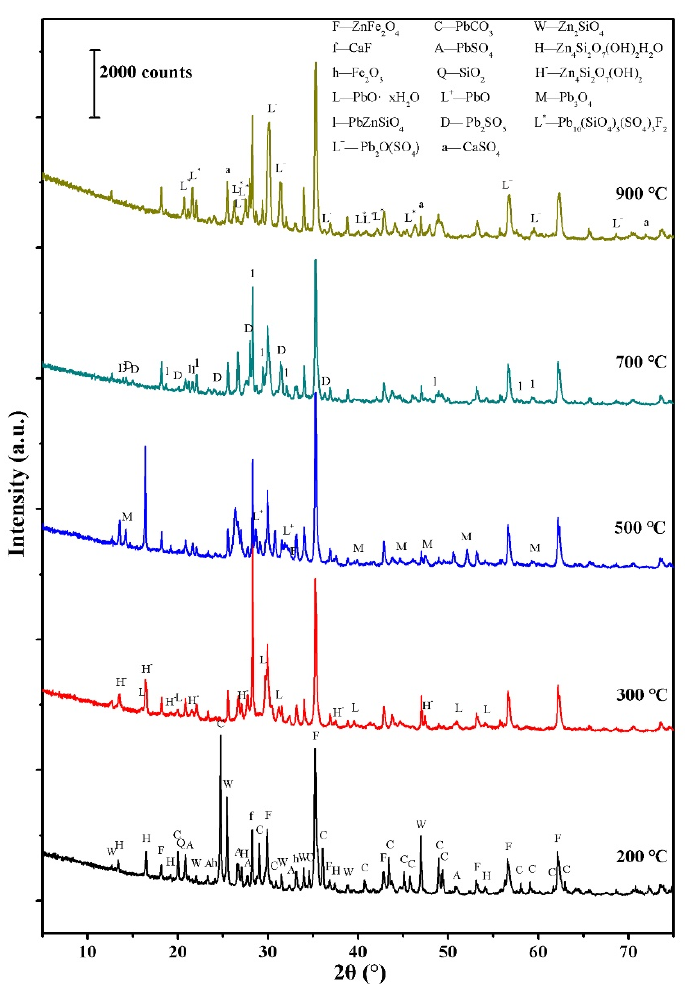
Figure 5. XRD analysis results showing the phase transformation of the zinc calcine (DZC-1) reheated at different temperatures.